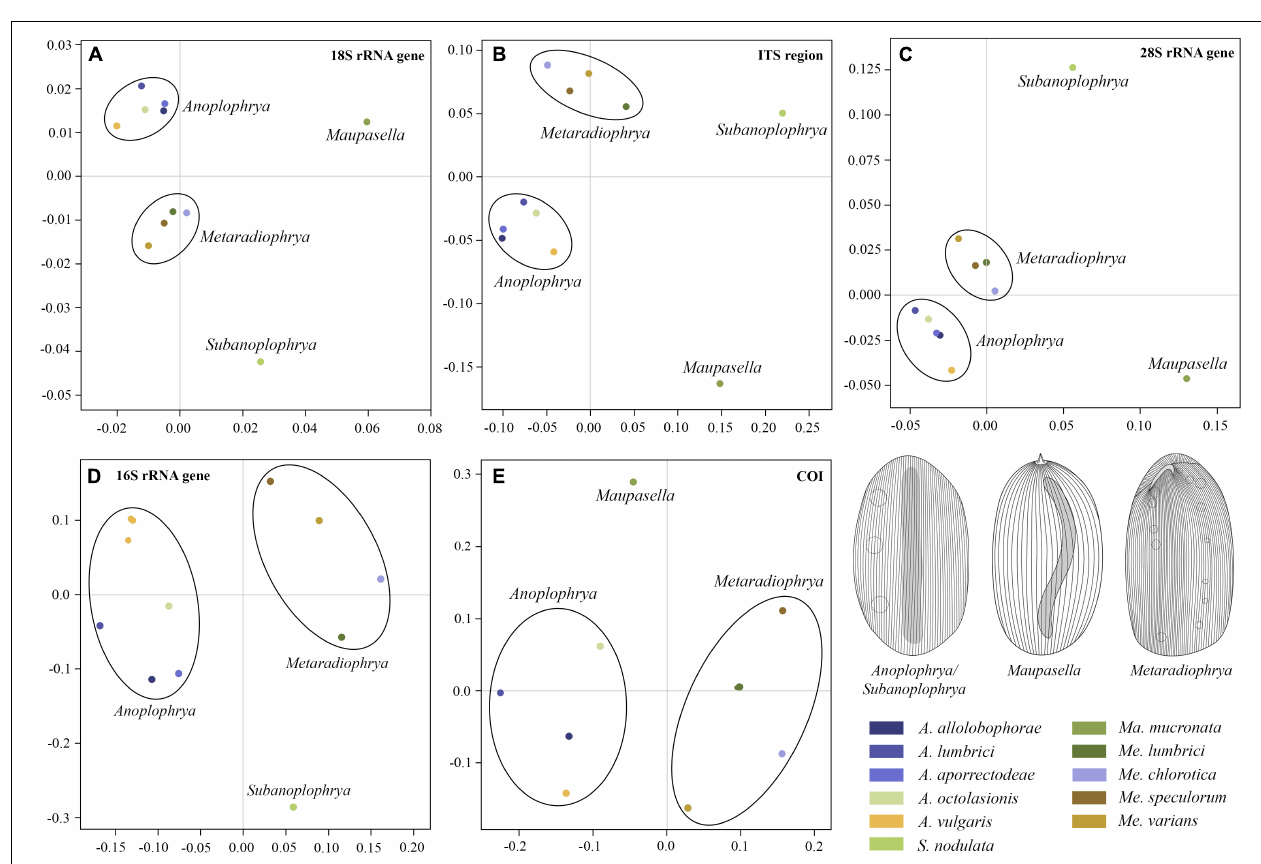
FIGURE 1 | Multidimensional scaling based on pairwise p- distances of the 18S rRNA gene (A) , the ITS1–5.8S–ITS2 region (B) , the first two barcoding domains of the 28S rRNA gene (C) , the mitochondrial 16S rRNA gene (D) , and the mitochondrial gene encoding for cytochrome c oxidase, subunit I (E) . For pairwise p- distances, see Supplementary Tables 5–9